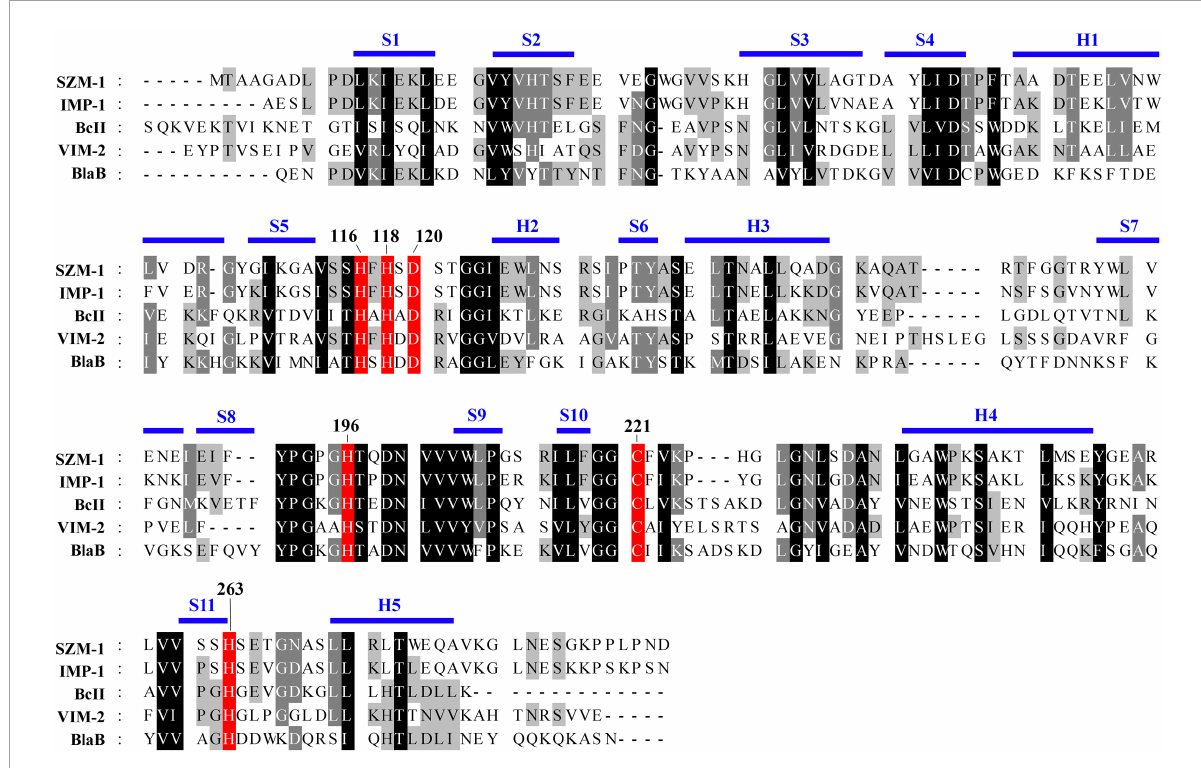
FIGURE3 Amino acid sequence alignment of SZM-1 and the representative class B1 MBLs. The conserved class B residues are highlighted with red color. The representative class B1 MBLs include IMP-1 (NCBI accession number: WP 003159548.1), BcII (WP 000742468.1), VIM-2 (WP 003108247.1), and BlaB (WP 029729112.1). Conserved secondary-structure (S, β -strand; H, Helix) are indicated above the sequences. The key residues involved in the coordination of the zinc iron are numbered according to the standard MBL numbering